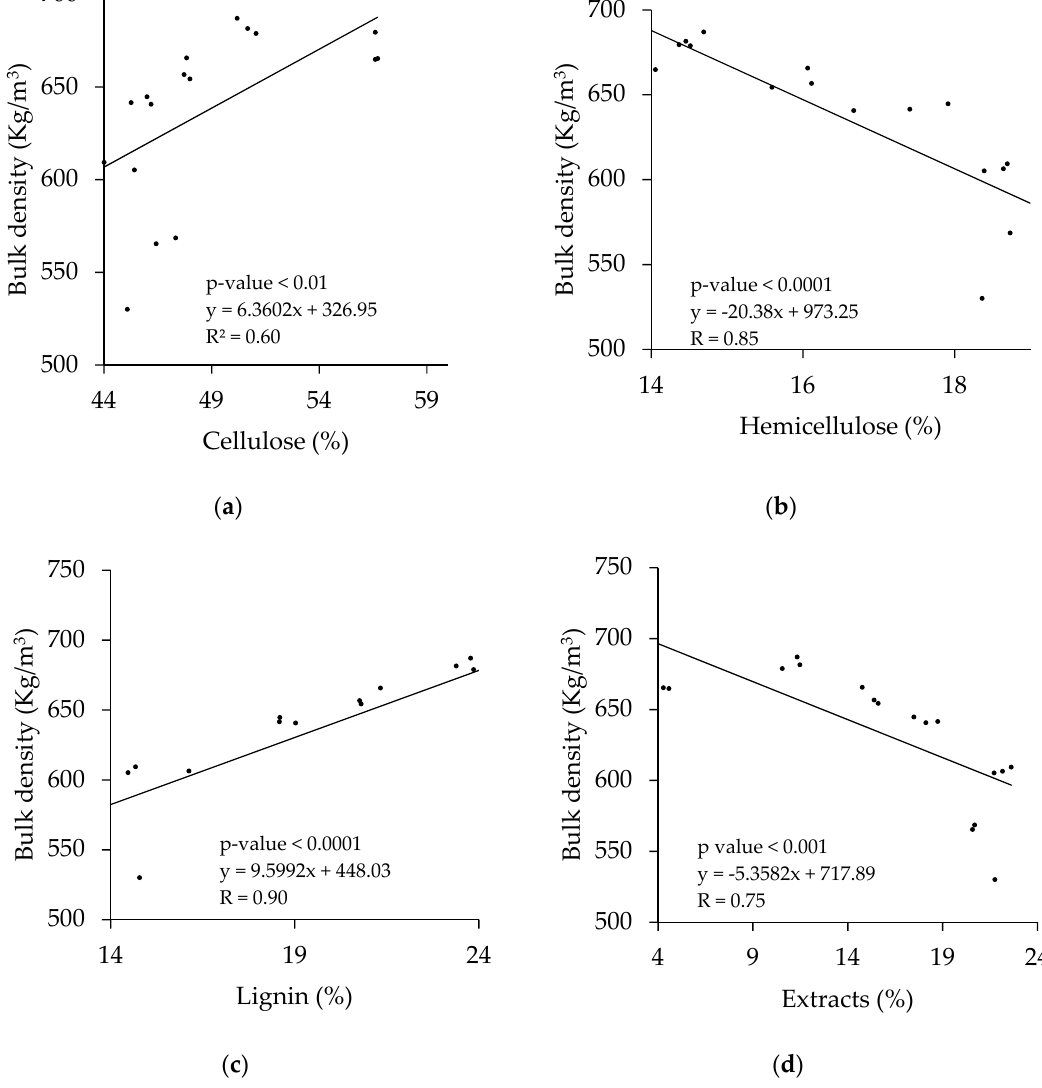
Figure 1. Relationship of agro-pellet bulk density with chemical components. ( a ) Cellulose; ( b ) hemicellulose; ( c ) lignin; ( d ) extract percentage of oil palm residues:pine sawdust mixtures. Bulk density of agro-pellets also showed a high degree of correlation coefficients ( r ) with oil palm residues:pine sawdust mixtures (R = 0.91, p < 0.001) and bulk density of oil palm residues:pine sawdust mixtures (R = 0.96, p < 0.01) (Figure 2).